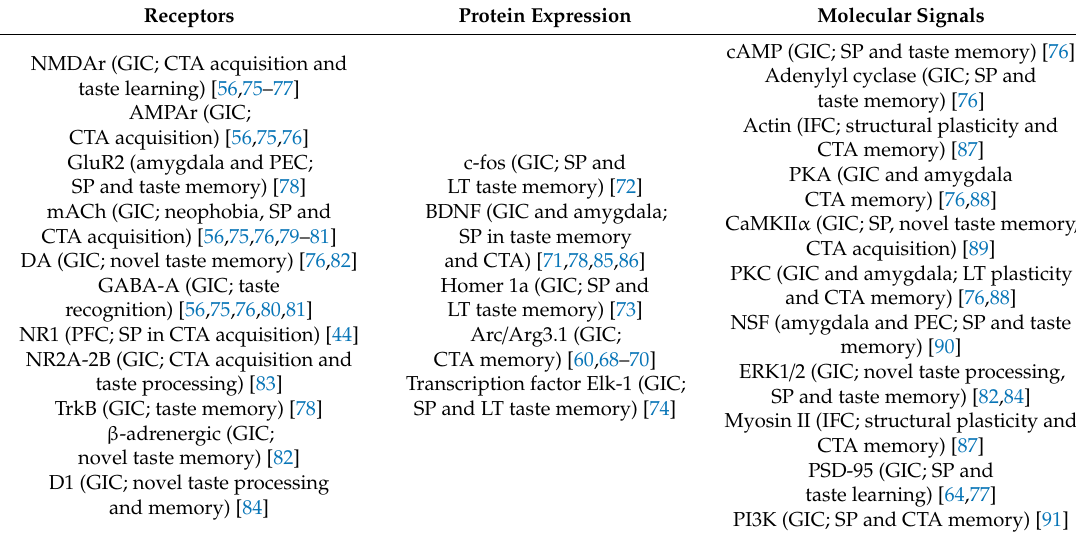
Table 1. Proteins, receptors and other molecules involved in taste learning. Brain regions and their functions related to these molecular processes are shown in